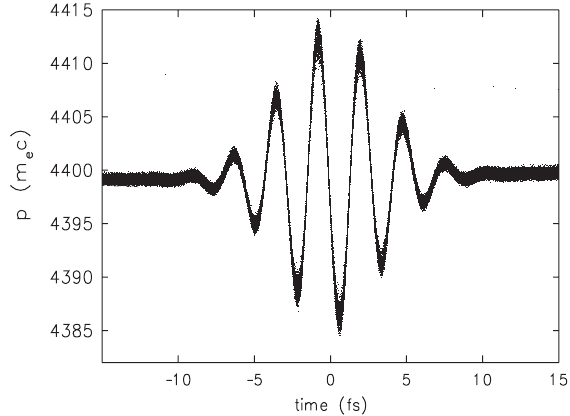
FIG. 2. Energy modulation given to the electron bunch by the combined undulator-laser interaction. An 800 nm, 5 fs FWHM, 0.4 mJ laser pulse was